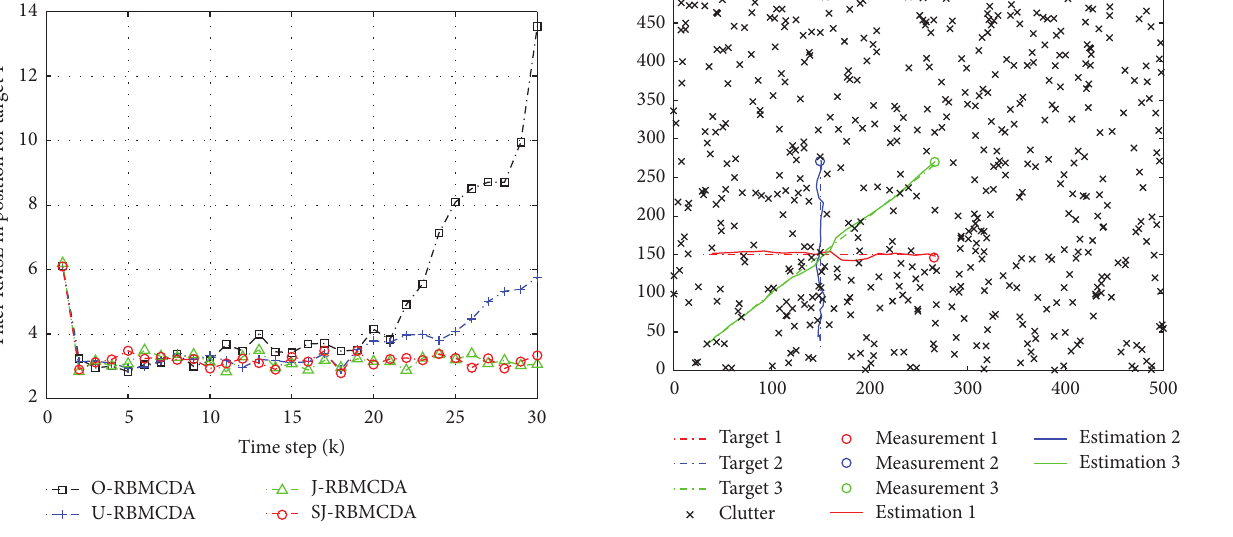
Figure 7: The average position estimation errors for target 1.